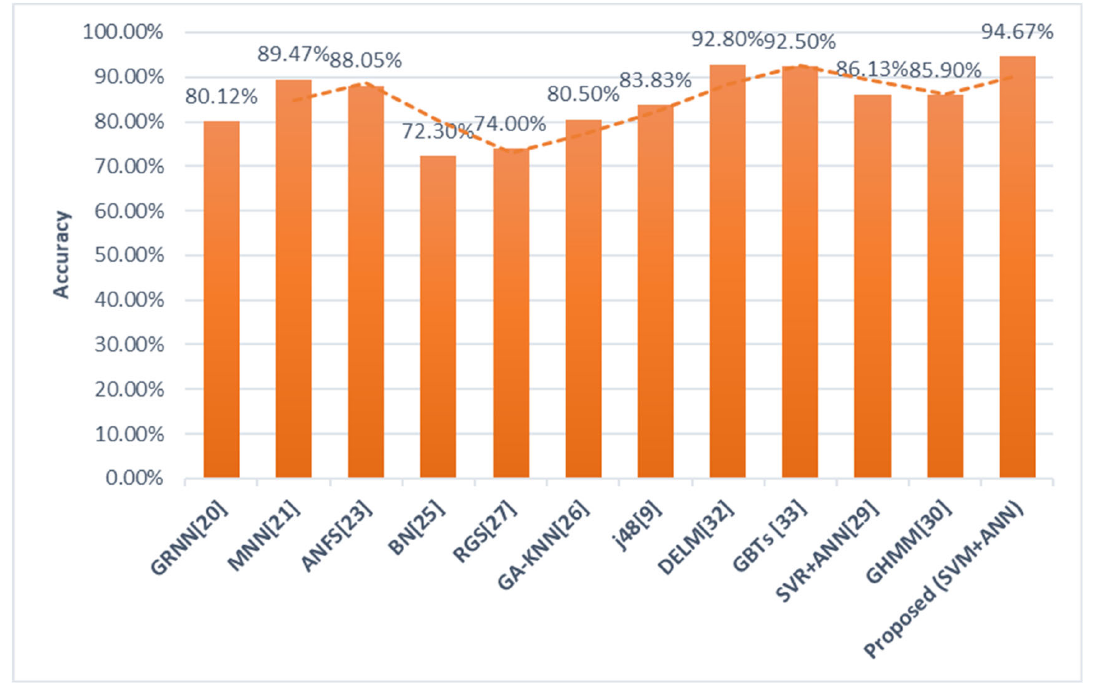
Figure 5. Performance Comparison of the Proposed Approach with existing Models in terms of Accuracy.